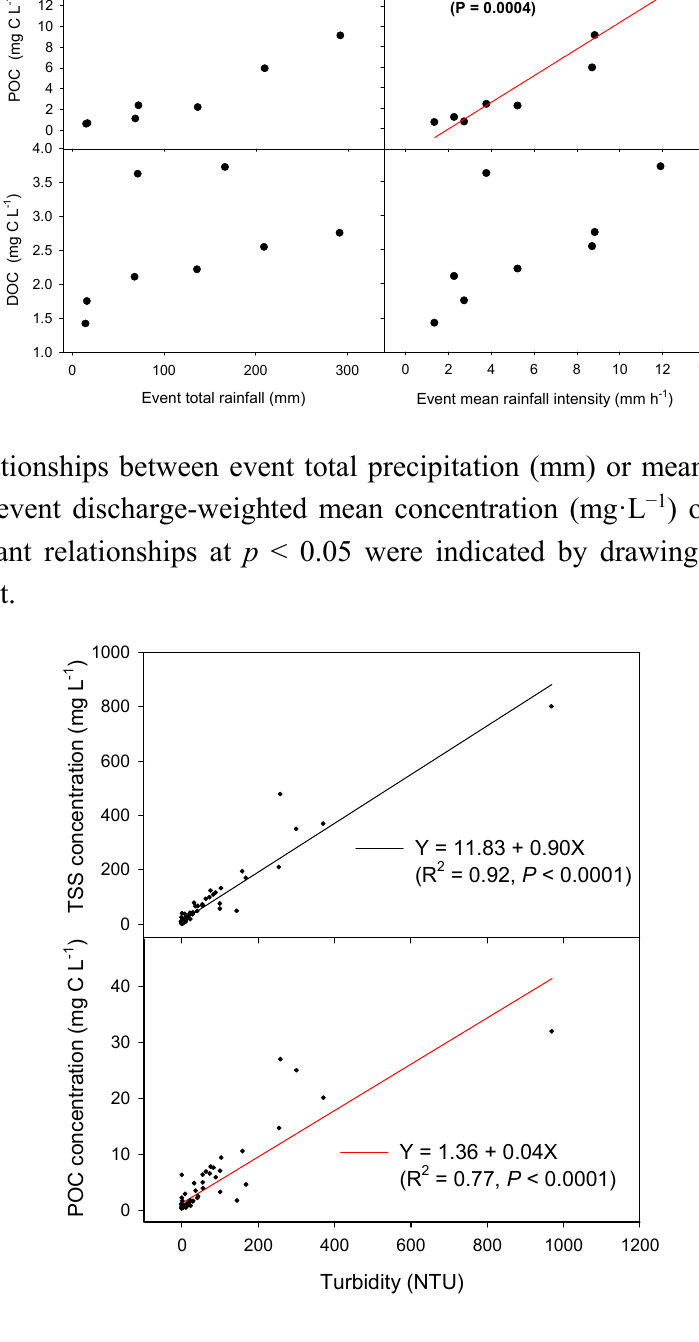
Figure 6. Relationships between turbidity (NTU) and the concentrations (mg·L − 1 ) of TSS ( n = 75) or POC ( n = 74) measured during eight rainfall